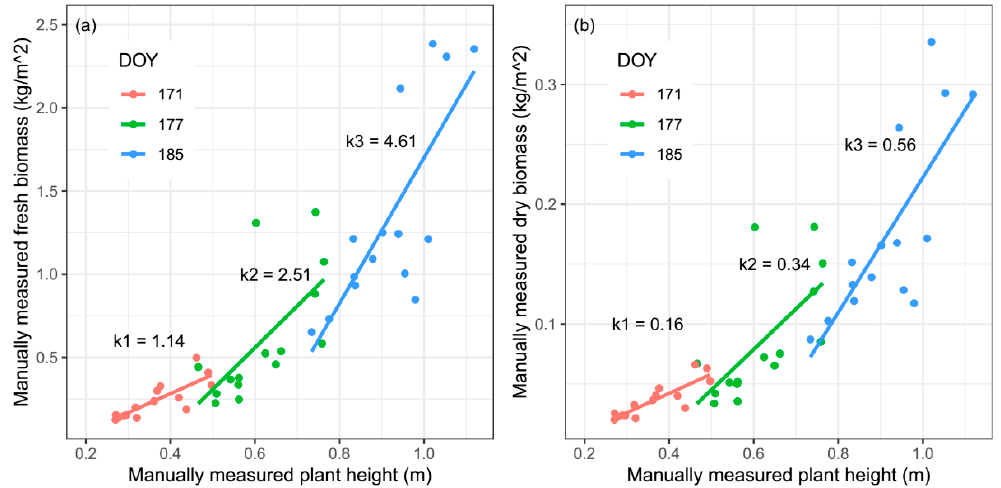
Figure 11. The changes of slopes of the linear regression models between manually measured maize plant height and biomass during DOY 170-185. ( a ) Fresh maize biomass; ( b ) dry maize biomass. k1, k2, and k3 represent the slopes of the linear regression models based on data collected on DOY 170, 177, and 185, respectively.